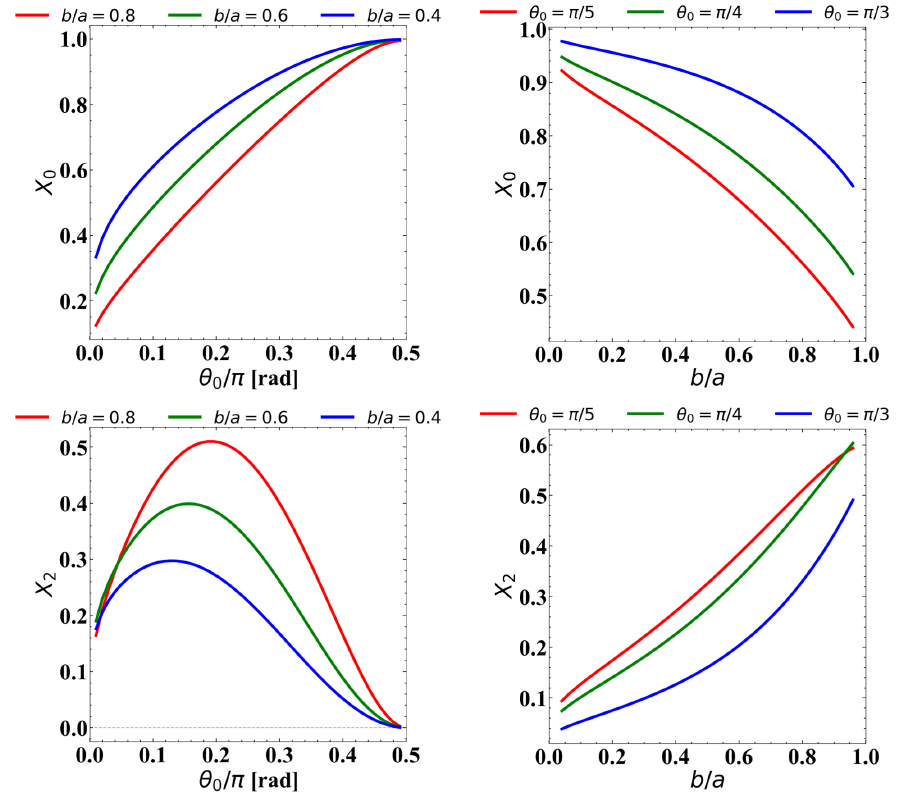
curve.FIG. 6. Even mode: Variation of the two lowest order coefficients with half coverage angle θ 0 for different values of b (left) and with b=a (right) for different values of θ 0 . Top row: X 0 , Bottom row: X 2